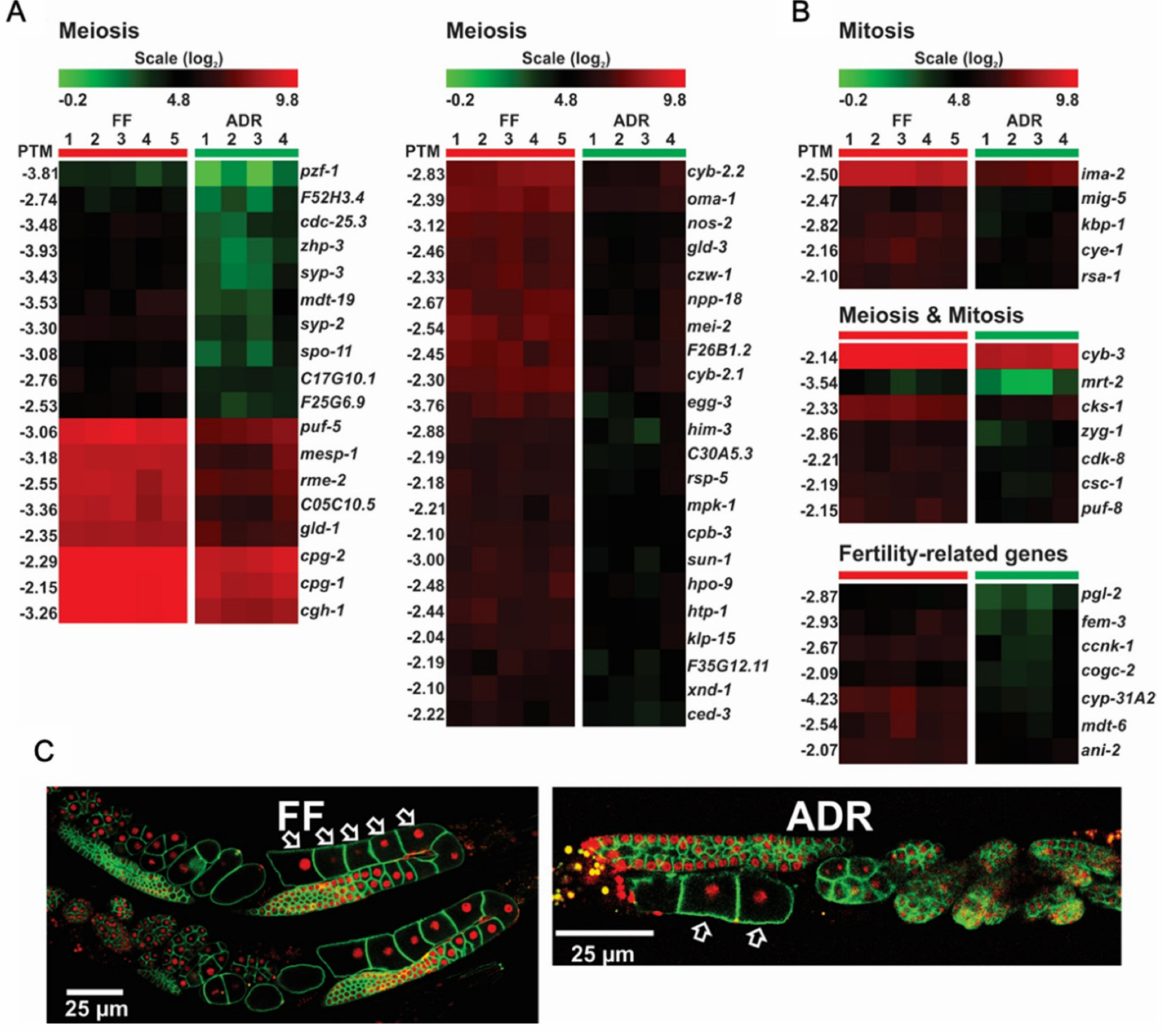
Figure 8. Differential expression of meiosis ( A ) and mitosis ( B ) genes in worms under fully fed (FF) and axenic dietary restricted (ADR) conditions. ( C ) Representative confocal images of go- nads of young adults (first day of adulthood) under FF and ADR conditions. Arrows indicate individual